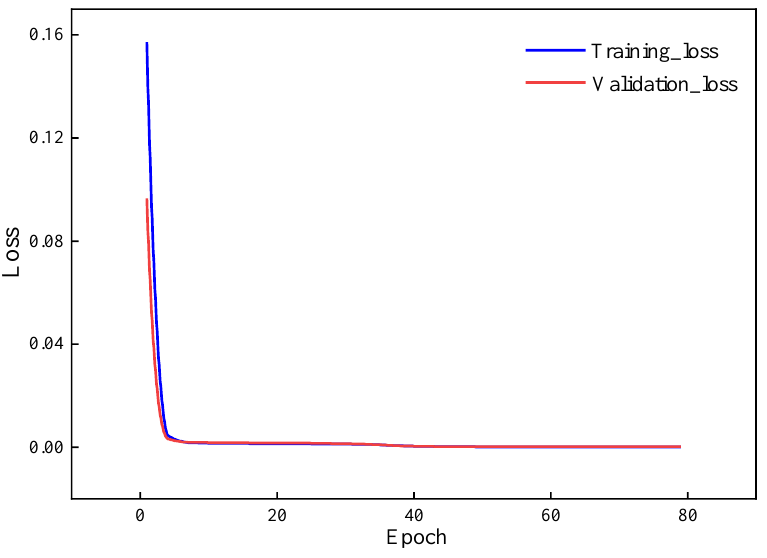
Figure 3. Training error of training set and validation set.